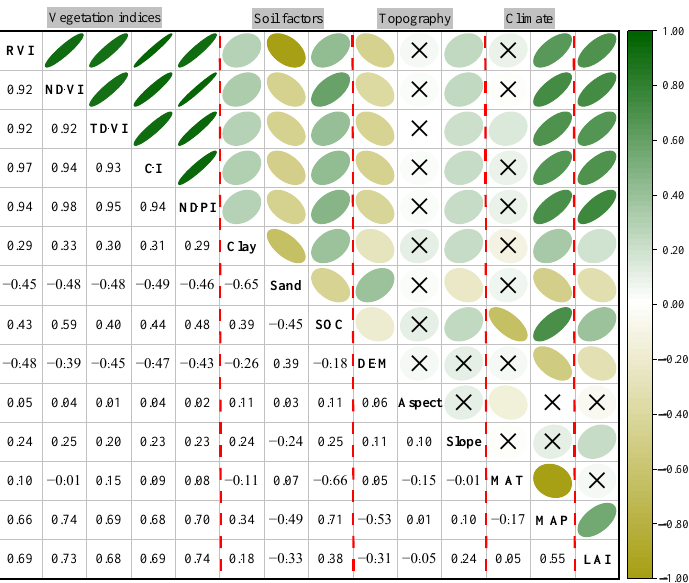
Figure 3. Correlation coefficients between the multiple variables and in situ LAI.